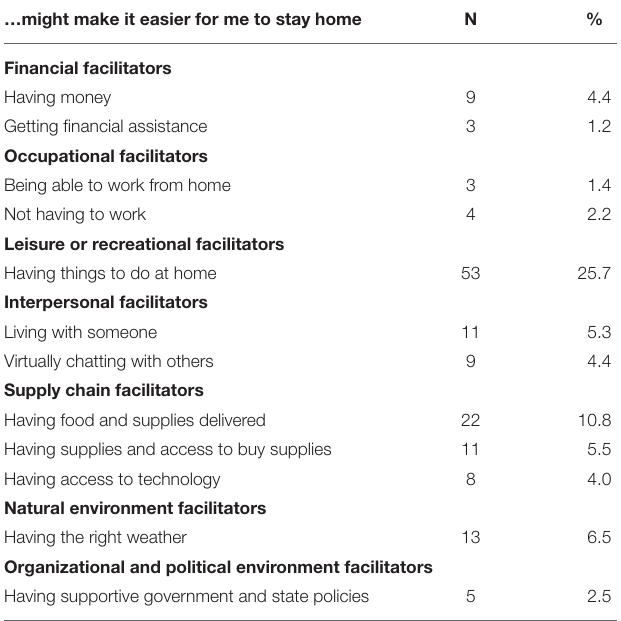
TABLE 5 | Frequency of perceived facilitators for staying home. …might make it easier for me to stay home N